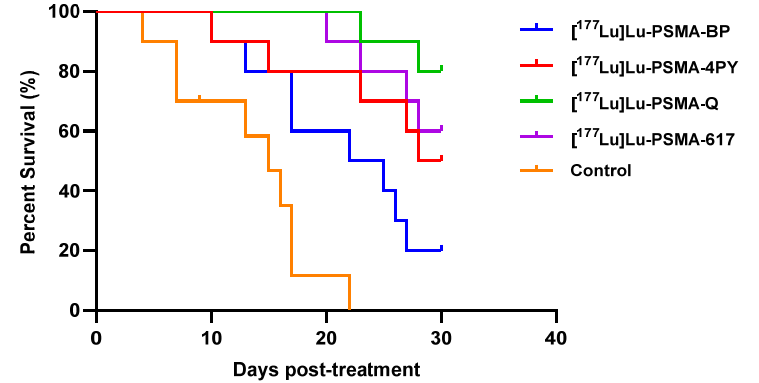
Figure 9. Survival curves of mice in different groups.